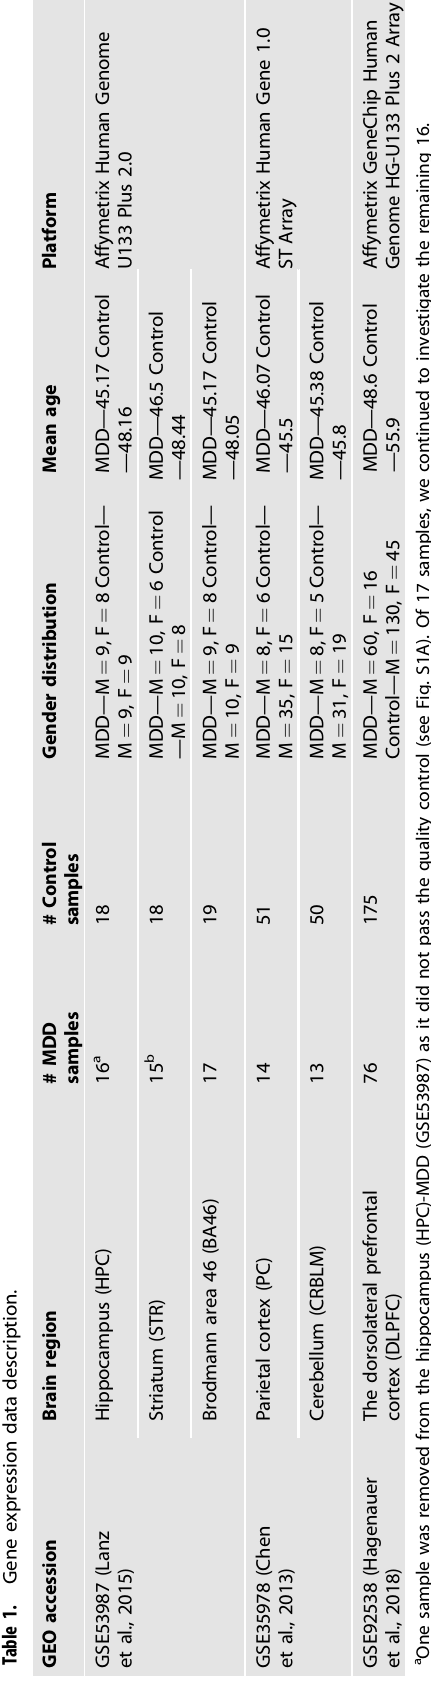
1. Gene expression data: Messenger RNA (mRNA) levels from post- mortem brain samples of individuals with MDD and healthy